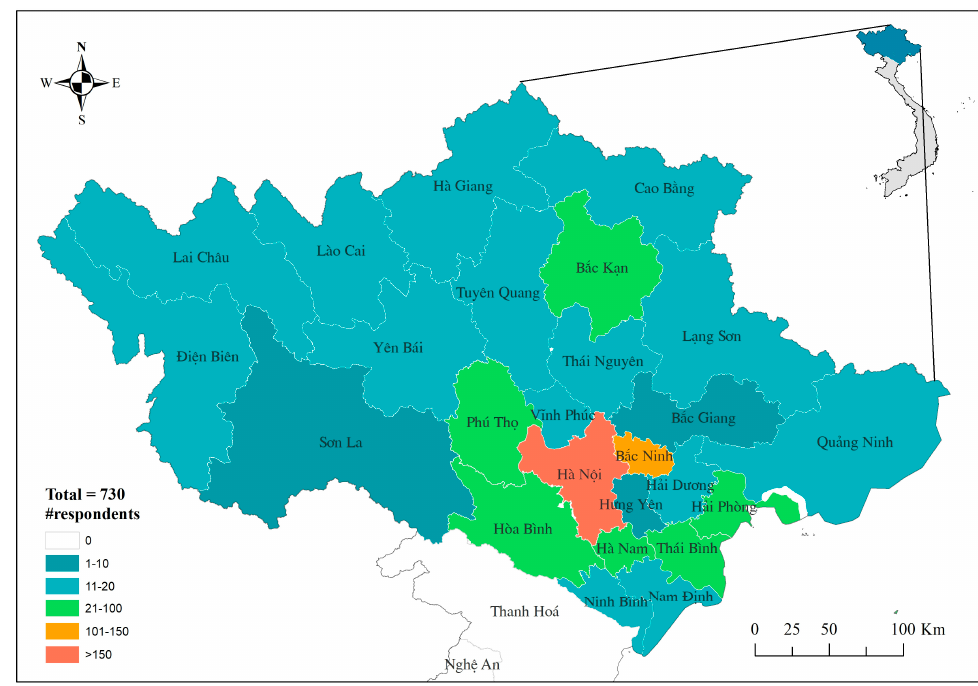
Figure 2. Map of the study